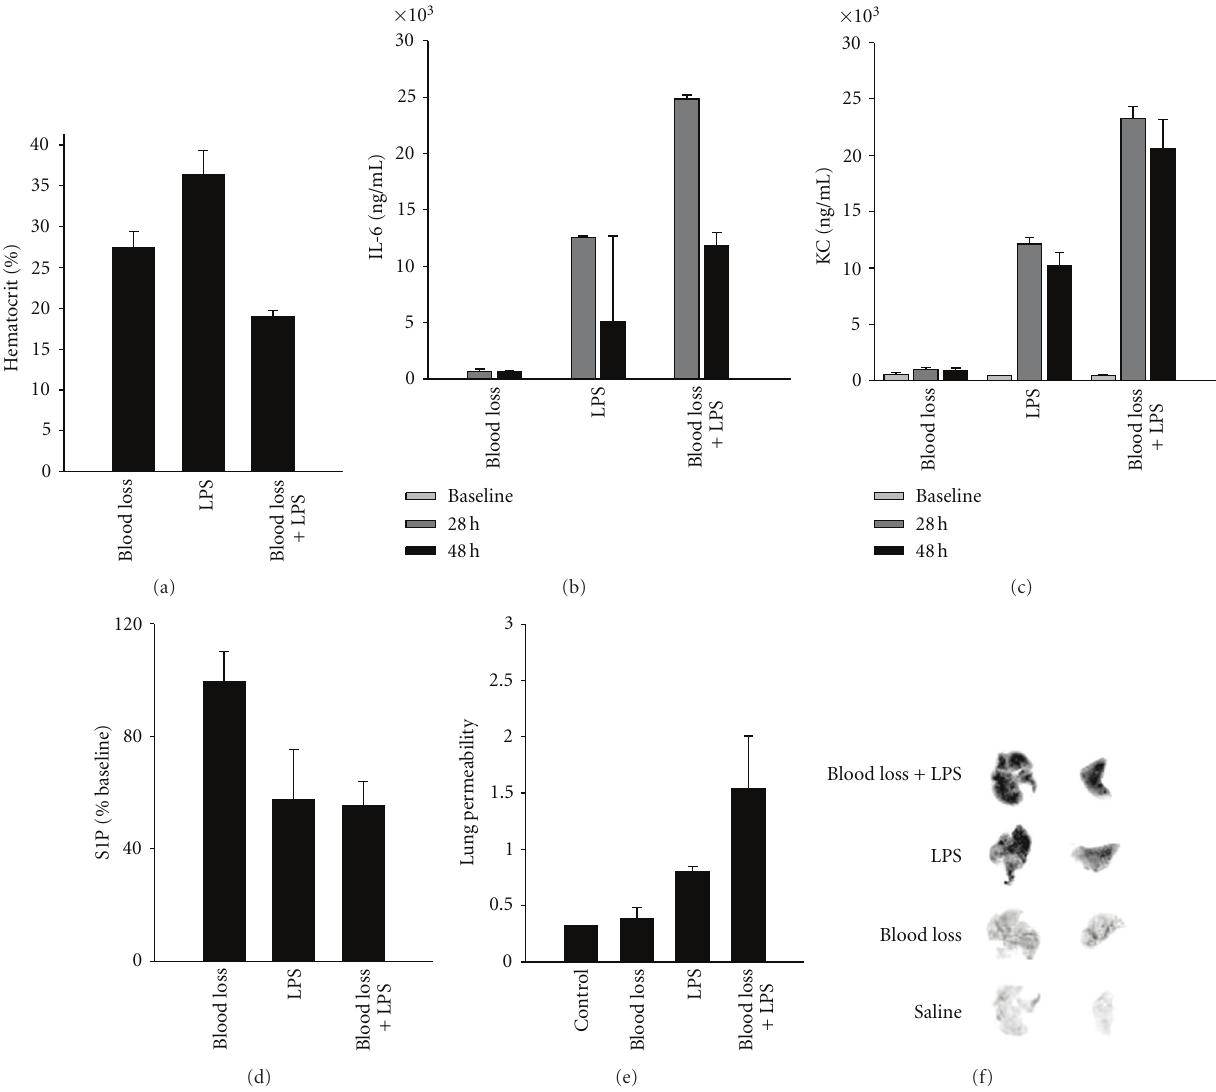
Figure 3: E ff ect of anemia on LPS-induced systemic inflammation and lung endothelial permeability. At time = 0 (baseline), mice were randomized in a 2:1 fashion to major blood loss (0.02mL/gm) or minor blood collection (0.002 mL/gm). Twentyfour hours later, mice that had undergone major blood loss (“blood loss”) were given vehicle or low dose LPS (2mg/kg, i.p.). Mice that had undergone minor blood loss were given LPS alone. (a) Hct was measured at 48 hours after initial blood loss ( n = 3 mice/group). (b) Plasma Il-6 and (c) plasma KC were measured at 28 hours or 48 hours after initial blood loss ( n = 3 mice/group). (d) Blood S1P was measured at 28 hours. (e) Quantification of EBD in the lungs, as a marker for endothelial permeability, was performed at 48 hours after initial blood loss ( n = 3/group). (f) Representative images of EBD in the lungs after the indicated treatments. Results were analyzed by one-way ANOVA (Bonferroni correction); ∗ P < 0 . 05 versus